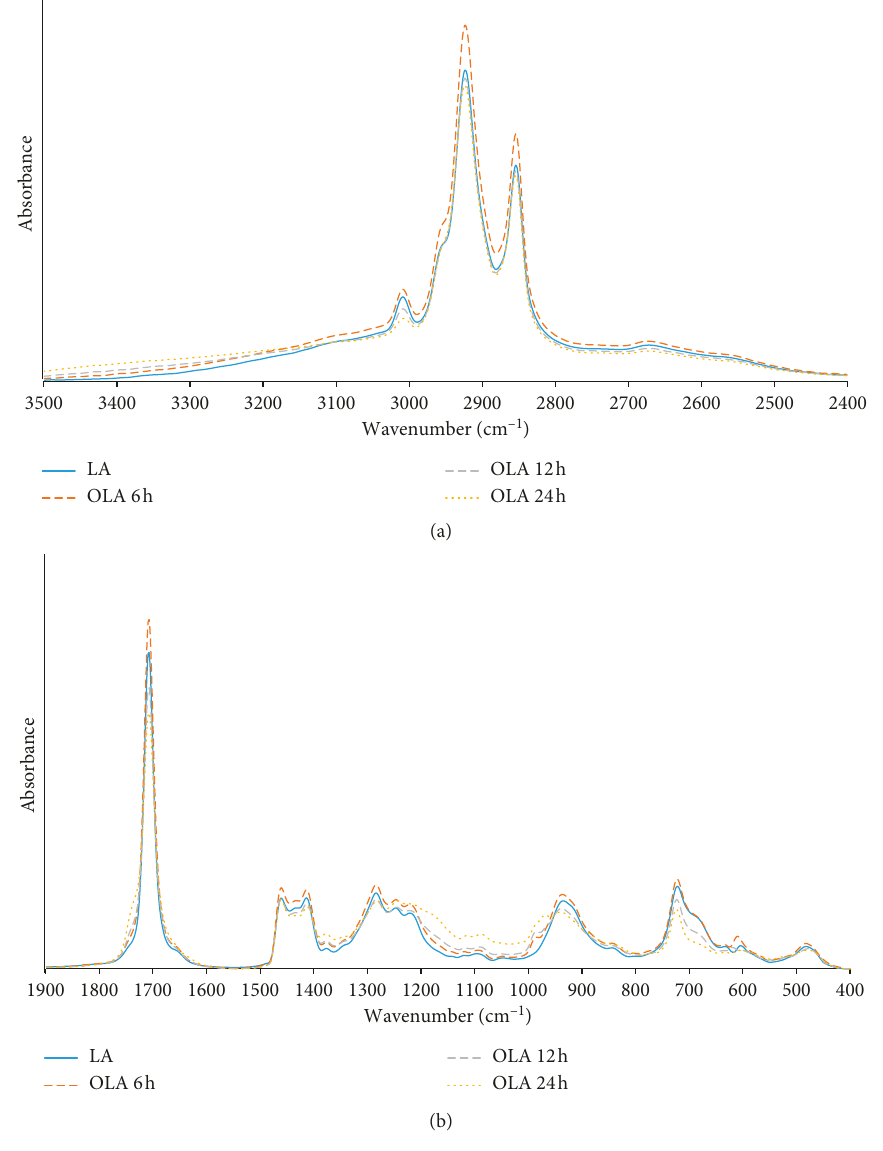
Figure 2: FTIR spectra in the wavenumber region of 3500–2400cm − 1 (a) and 1900–400cm − 1 (b) of linoleic acid (LA) and OLA prepared at 60 ° C for different oxidation